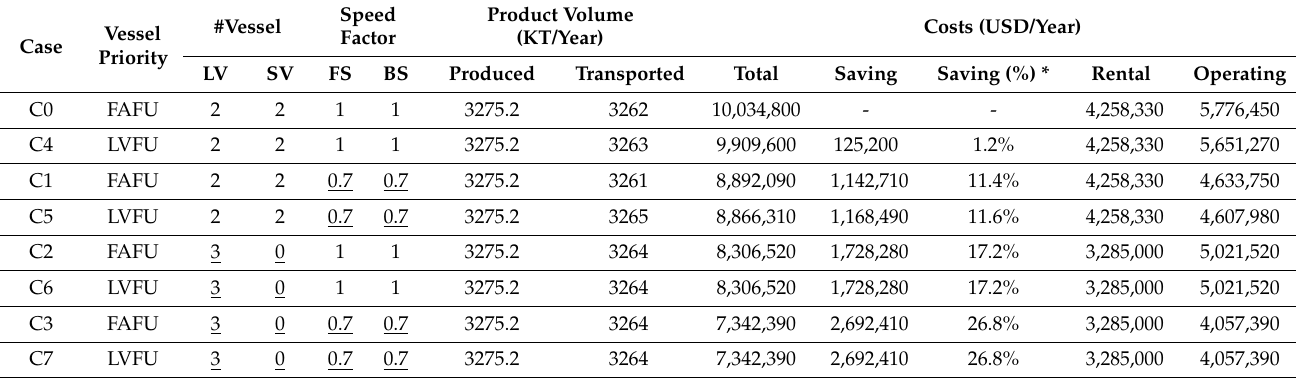
Table 7. Comparison of vessel selection rule from the best results of all